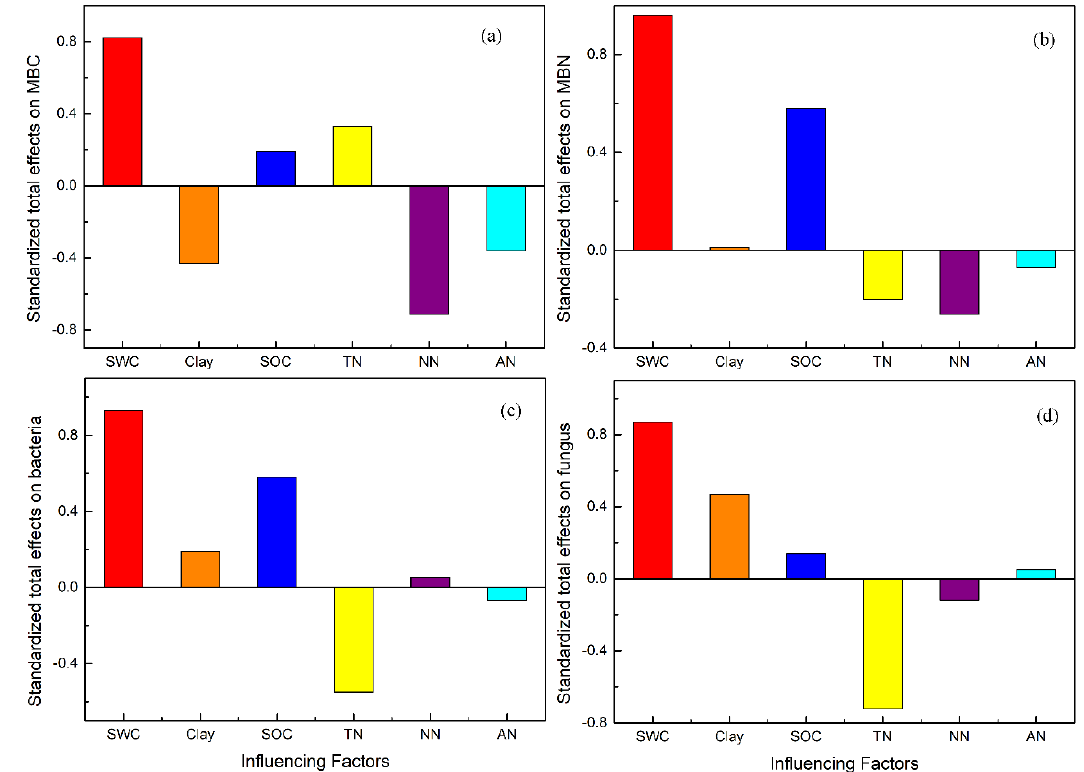
Figure 8. Standardized total effects on microbial biomass carbon (MBC) ( a ), microbial biomass nitrogen (MBN) ( b ), bacteria abundance ( c ) and fungi abundance ( d ). SWC, soil water content; Clay, soil clay content; SOC, soil organic carbon; TN, soil total nitrogen content; NN, soil nitrate nitrogen; AN, soil ammonium nitrogen content.